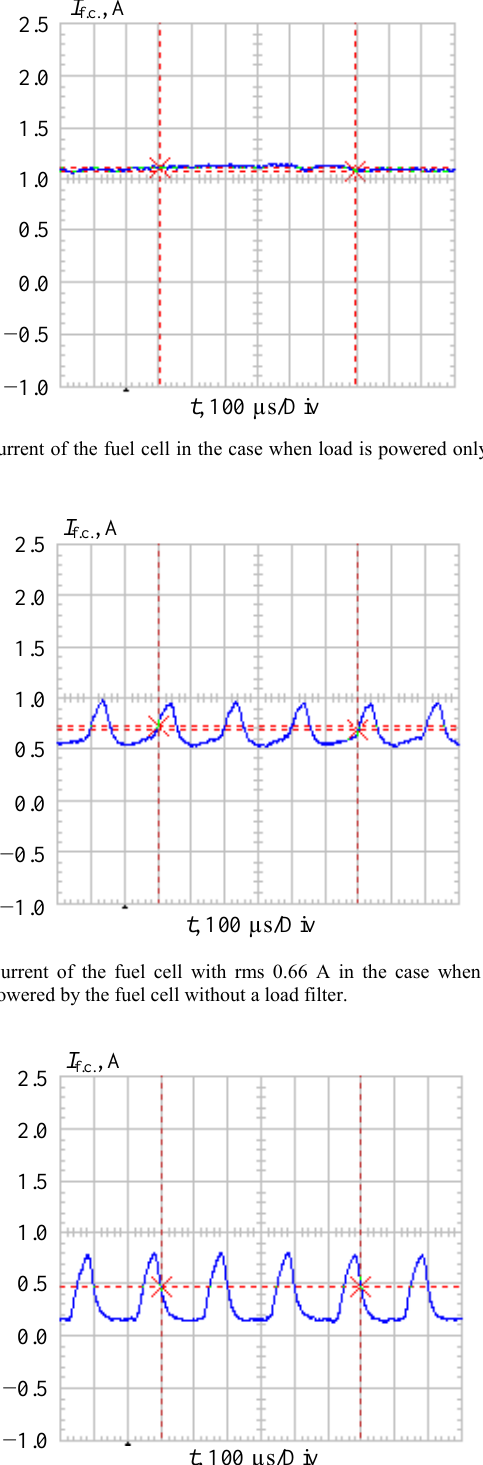
Fig. 14. Current of the fuel cell with rms 0.32 A in the case when load is partially powered by the fuel cell with a load